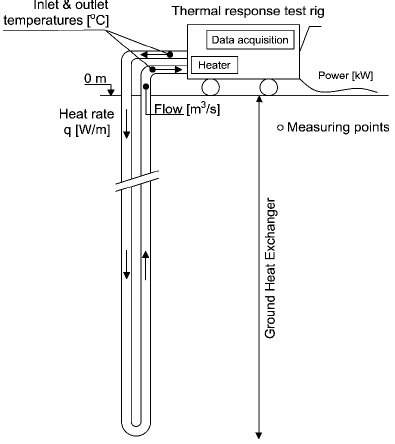
Figure 9. Thermal response test setup, after Reference [86].